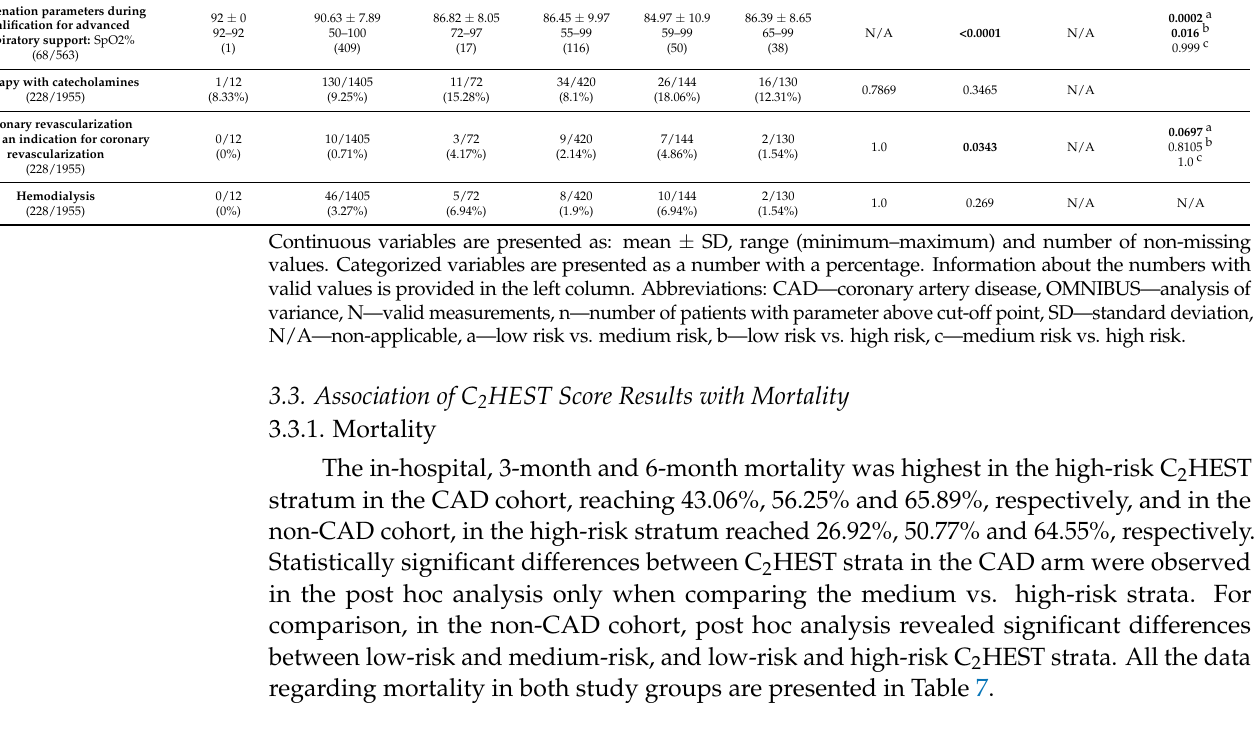
Table 7. Total and in-hospital all-cause mortality in the C 2 HEST risk strata in CAD and non- CAD